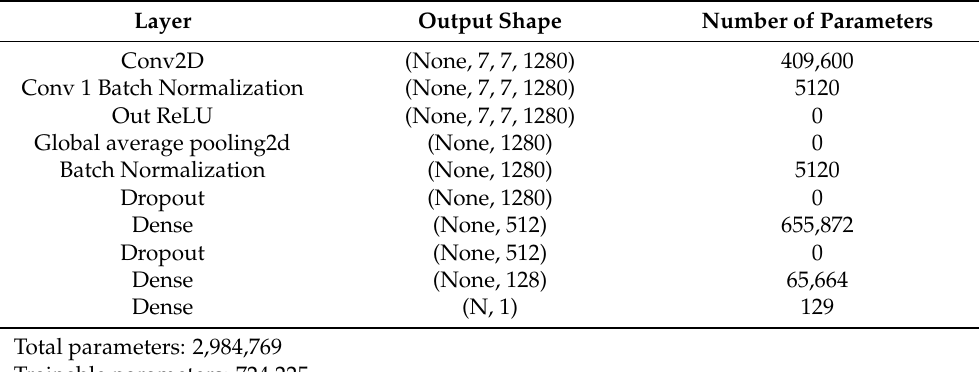
Table 9. Summary of the custom layers added to the pre-trained MobileNet-v2 model for skin classification